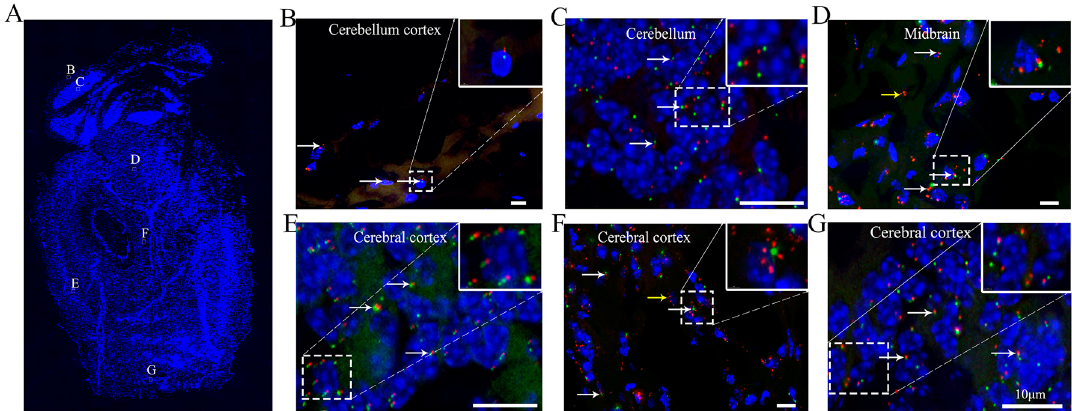
Figure 4. The cilia in the cerebral cortex are well, pointing to the center of the brain. ( A ) Sagittal sections of the brain, ( B ) cerebellar cortex, ( C ) cerebellum, ( D ) midbrain, and ( E – G ) cerebral cortex. Many ARL13B+ particles are visible in ( F ). White arrow, cilium with axoneme and basal body. Yellow arrow, localization of ARL13B. Red arrow, cells with only Centrin2. Green, Centrin2-GFP. Red, ARL13B-mCherry. Blue, DAPI. Scale bar, 10 µ